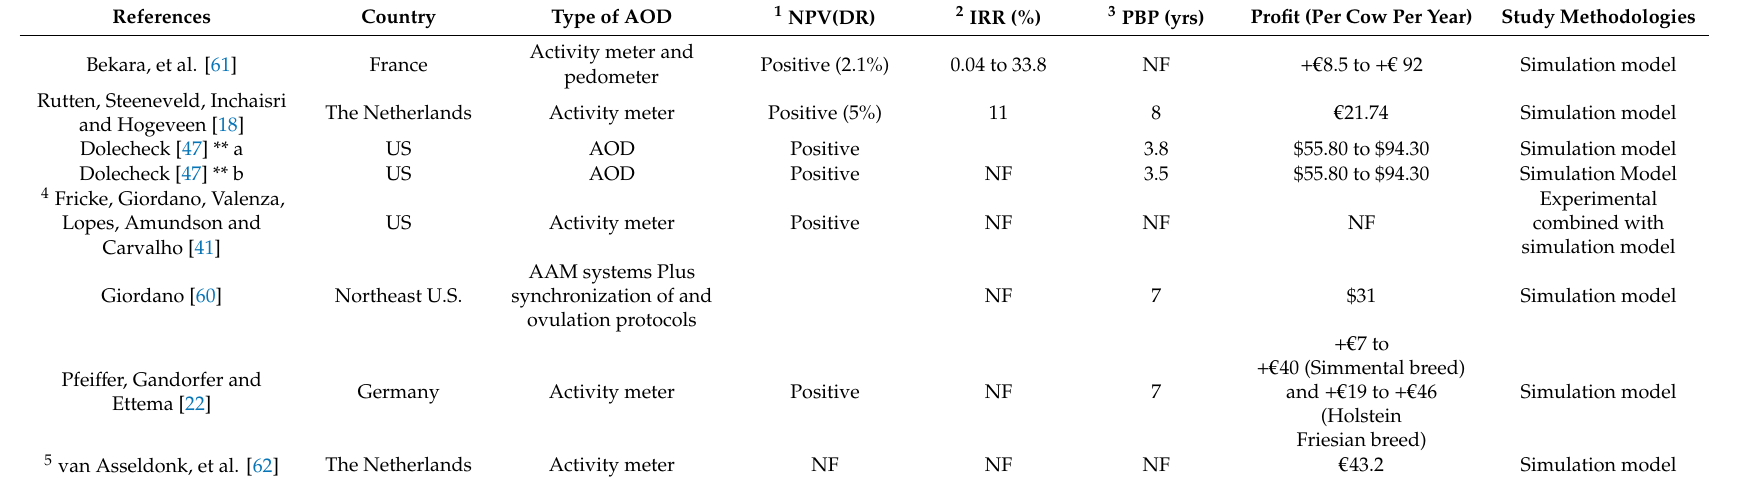
Table 1. Economics of investment in automated oestrus detection (AOD) technologies for di ff erent dairy farm